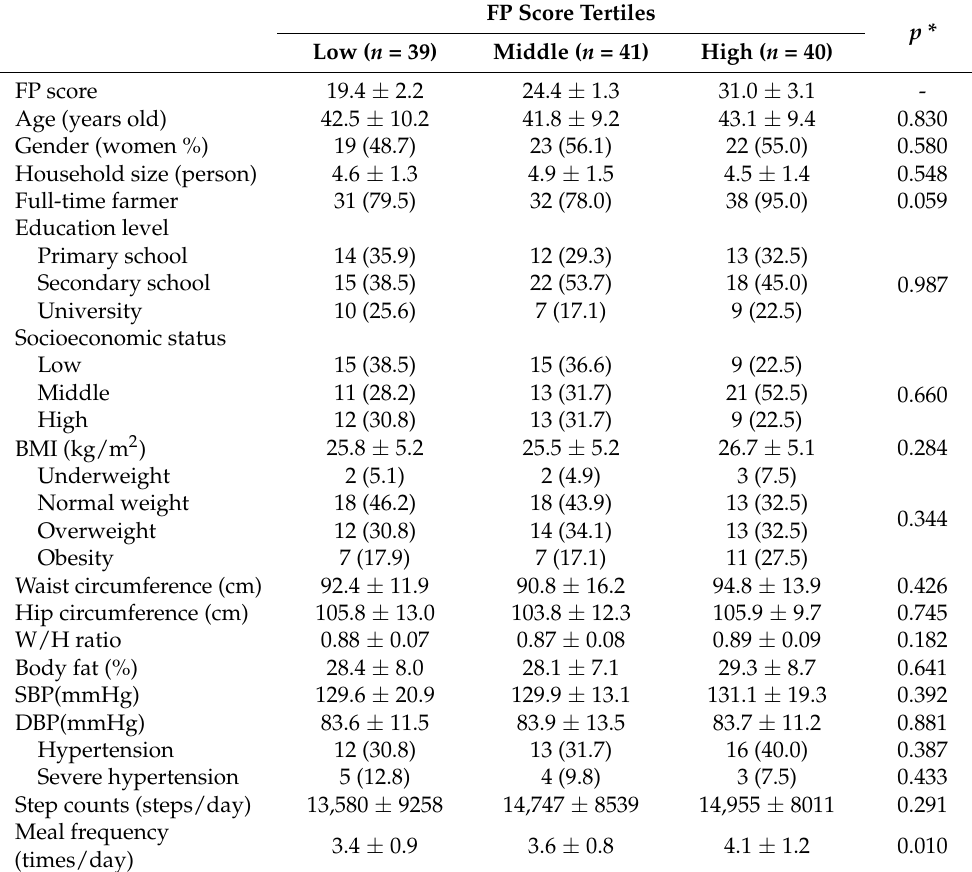
Table 2. Characteristics of